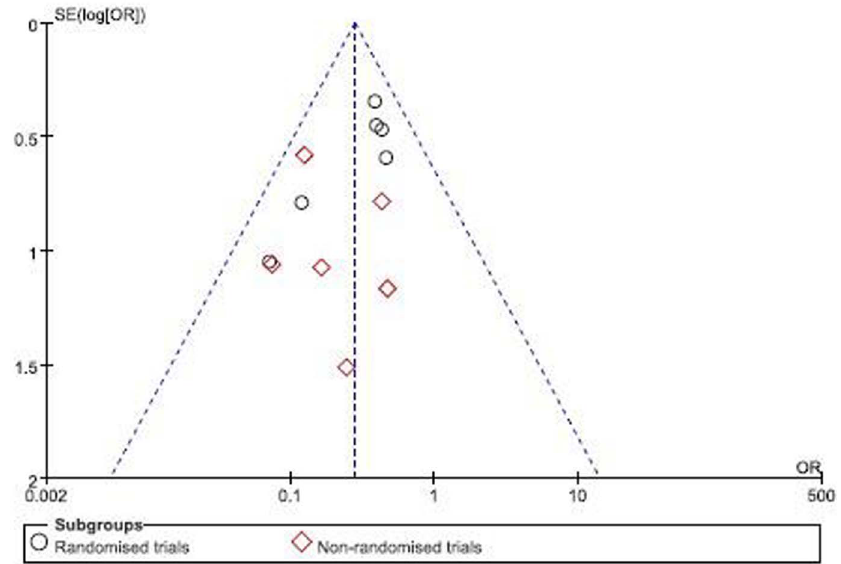
Figure 3. Results of the meta-analysis on studies evaluating the effect of PCI on overall survival: HR: 1.19 (95% CI: 1.06–1.33).